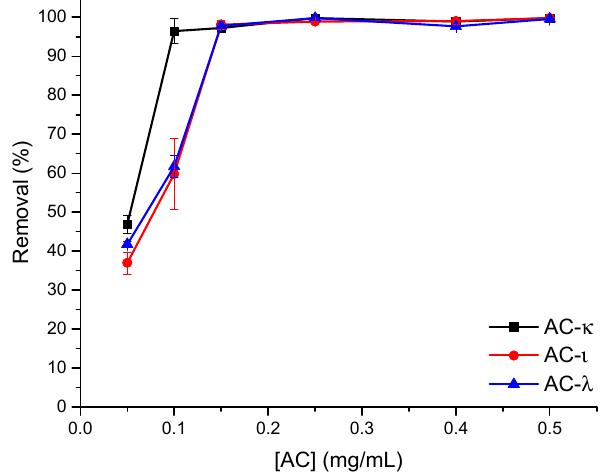
Figure 8. Effect of the adsorbent dosage in the removal of CIP from water, using the carrageenan-based activated carbons (conditions: 50 mg/L CIP, pH = 6, 24 h contact time).